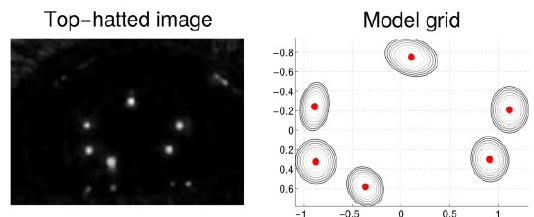
Figure 7. An example of a top-hat operated eye image which is cropped according to the estimated pupil center and filtered. Right: An example of a model grid. Red dots depict the mean values of the grid and the contour lines represent the covariance of each grid point. Note that in the conventional image coordinate system, the vertical coordinates increase